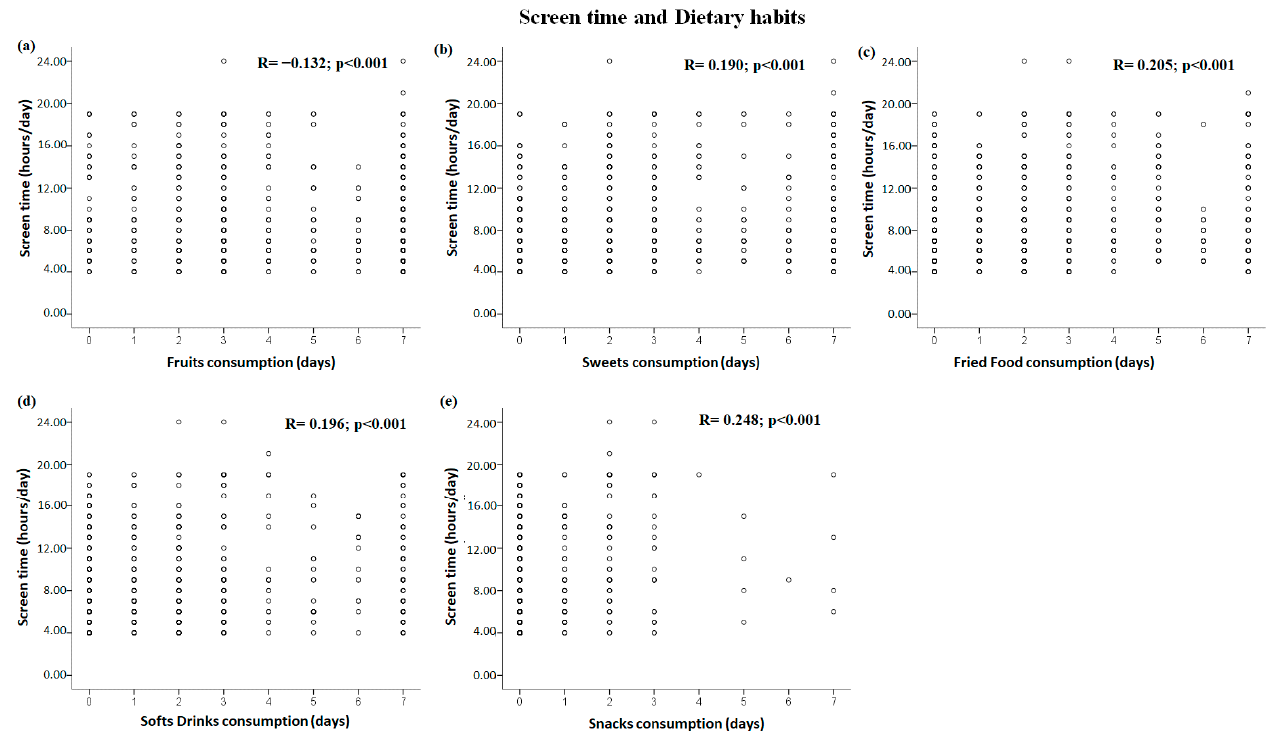
Figure 3. Significant correlations between dietary habits and screen time domain: ( a – e ) correlations between screen time and fruit, sweets, fried food, soft drink, and snack consumption, respectively. Table 2. Associations between body mass index (global adiposity) and dietary patterns in adults. Body Mass Index (Global Adiposity)